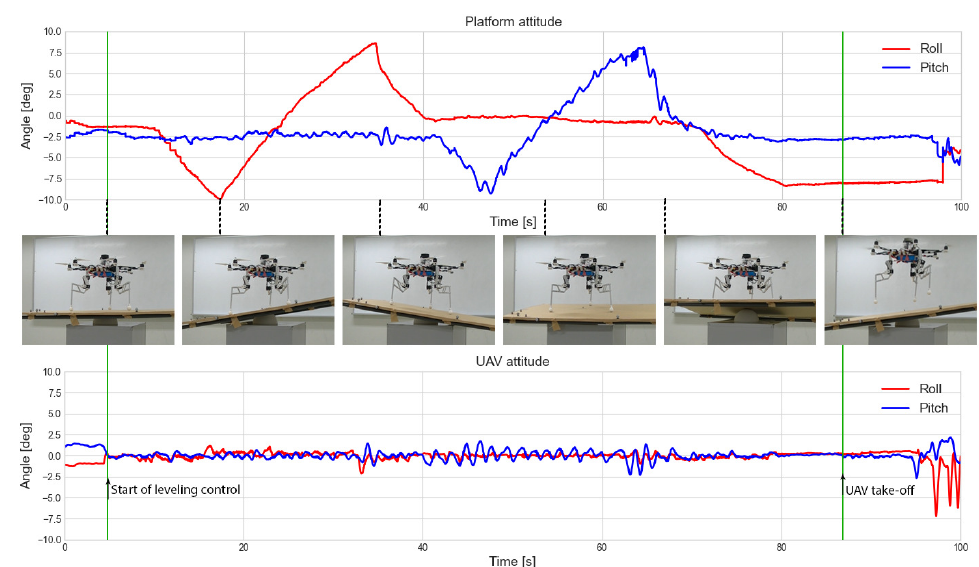
Figure 11. Roll and pitch angles of the UAV and platform attitude during the experiment to maintain the airframe horizontal against surface slope